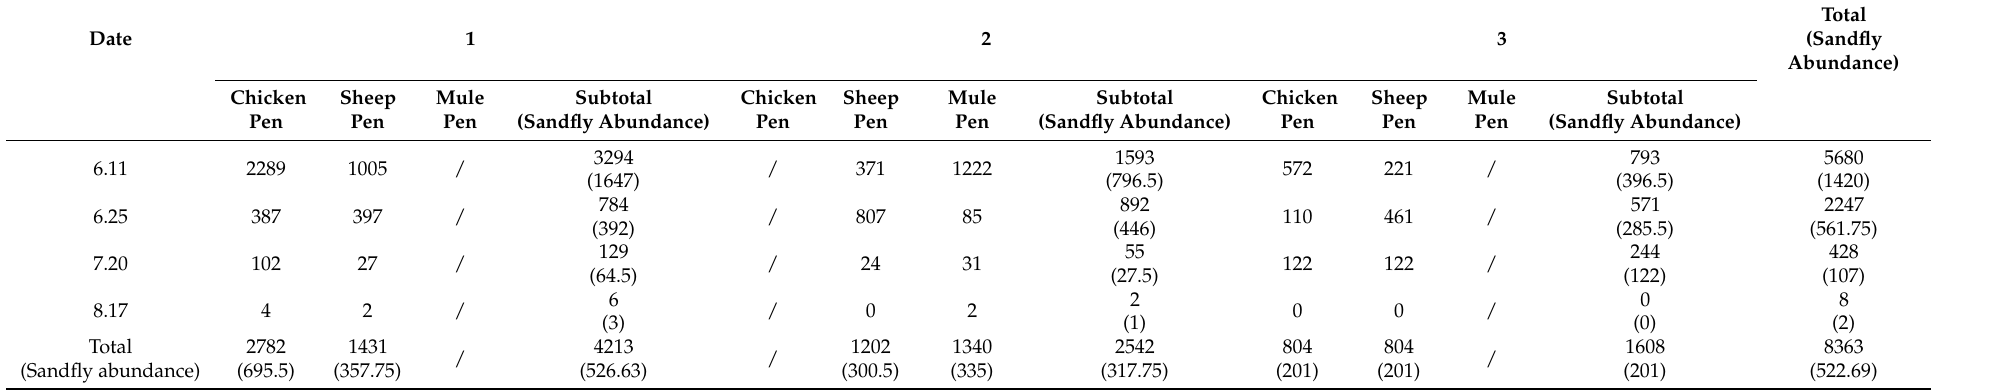
Table 1. Specimen collection in Yangquan County, Shanxi Province in